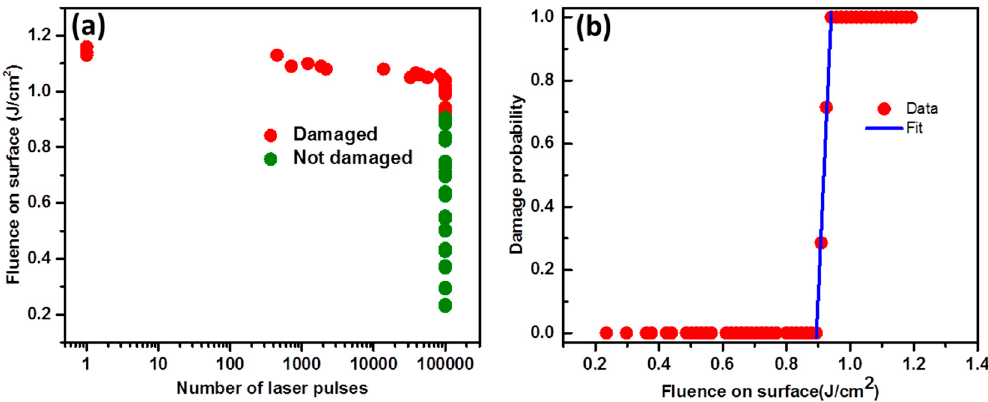
Figure 3. ( a ) Incident laser fluence on the sample surface vs. number of laser pulses for 100k-on-1. ( b ) The damage probability vs. the laser fluence on the sample surface at 45 deg Angle of Incidence (AOI).